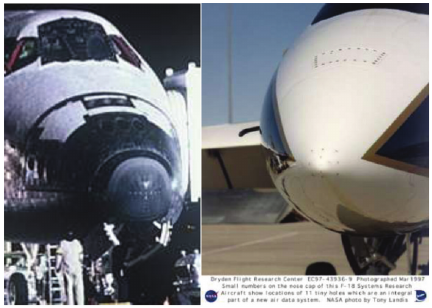
Figure 2: FADS Ports on Space Shuttle Columbia and F-18 [21].